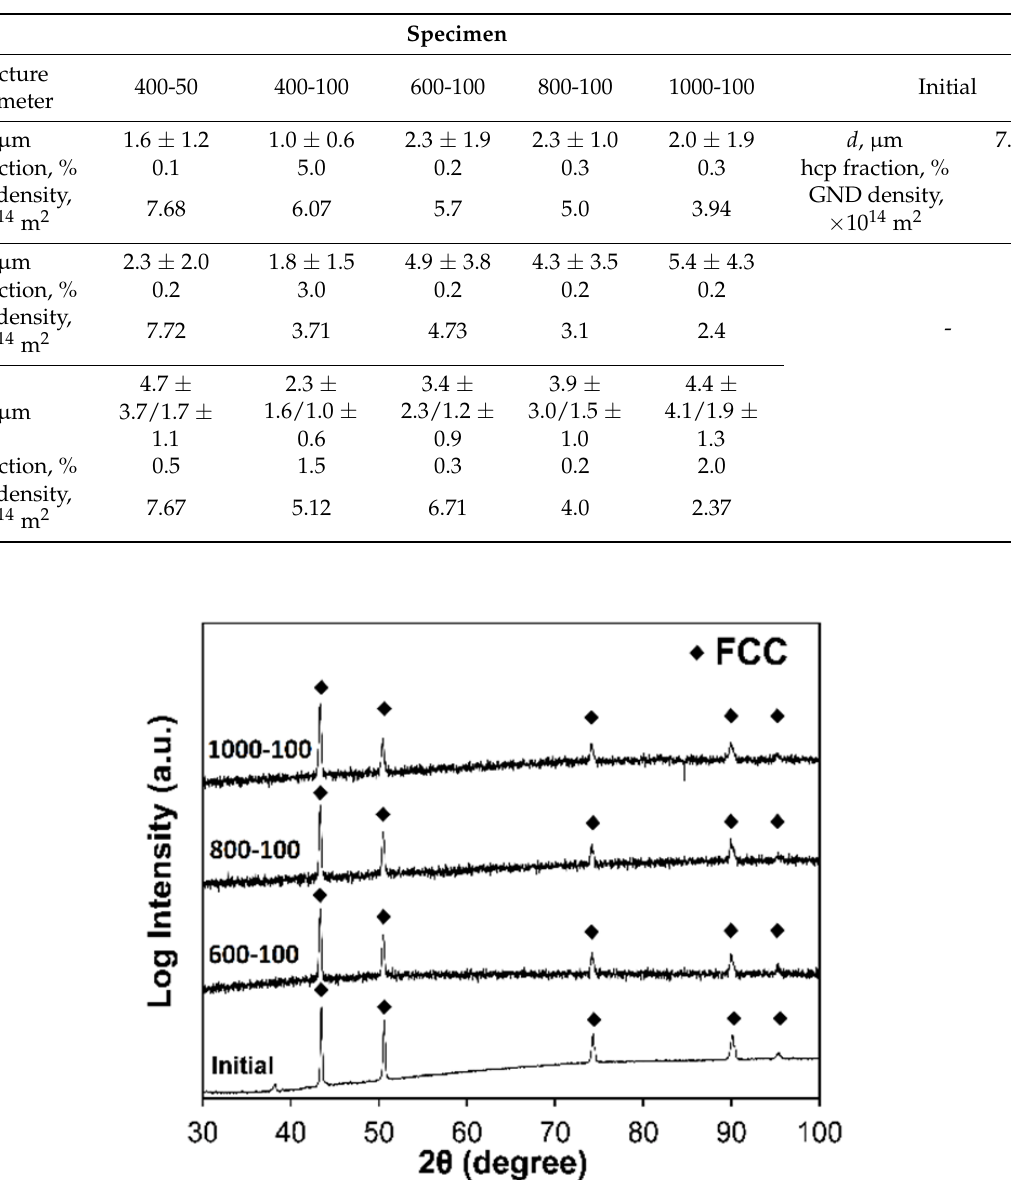
Table 2. Average grain sizes, hcp phase fraction, and GND density in areas #1–3 in Figure 3a for different parameters of FSW. The data for the initial alloy is shown for the comparison. In area #3, the size of coarse/fine grains is shown before/after slash symbol, respectively.